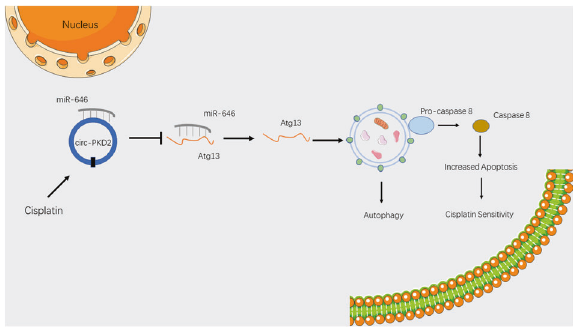
Fig. 6 Circ-PKD2 promotes Atg13-mediated autophagy by inhi- biting miR-646 to increase the sensitivity of cisplatin. Schematic diagram depicting the proposed model in which circ-PKD2 regulates autophagy and cisplatin